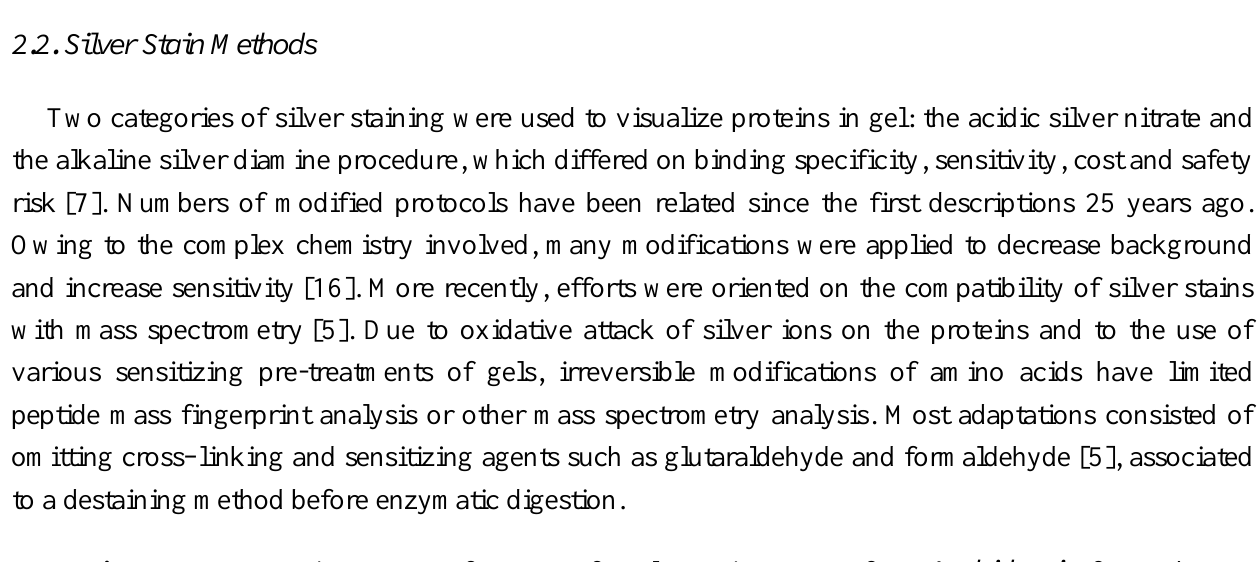
Figure 3. 2D protein patterns of 100 µg of total protein extracts from Arabidopsis , focused on the pI 4–7 range, separated on gels covering the 15–150 kDa range and stained with colloidal Coomassie blue, silver nitrate, Sypro Ruby and Deep